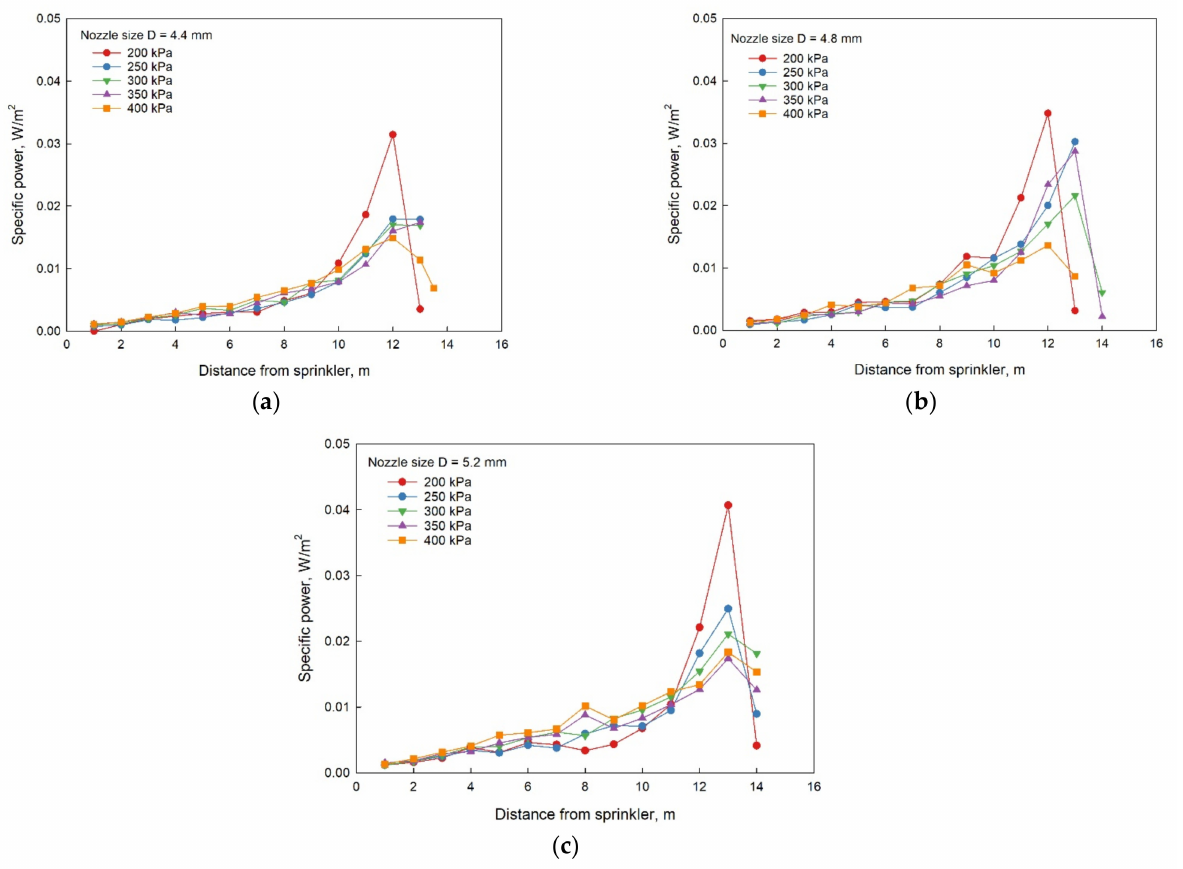
Figure 11. Specific power as a function of radial distance from the sprinkler with nozzle sizes of